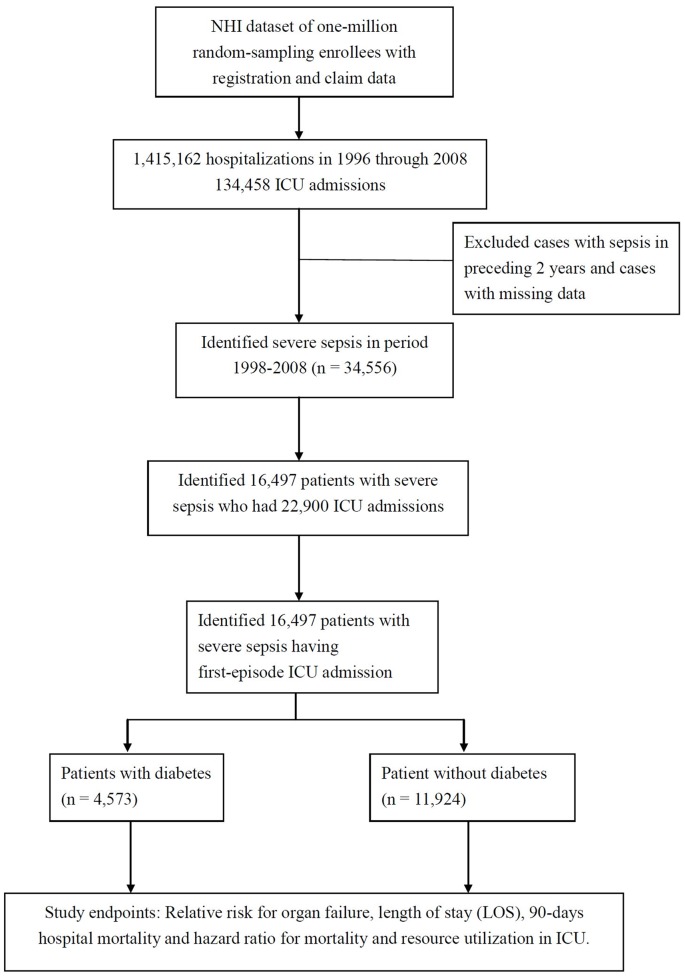
The Study Flowchart.